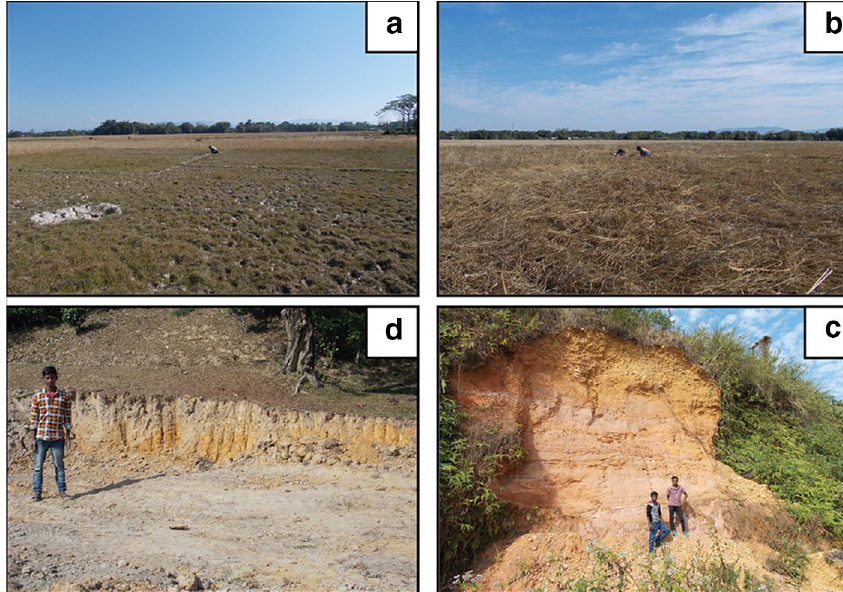
Fig. 3 Terrain characteristics and surface soil/sediment covers of the study area during dry